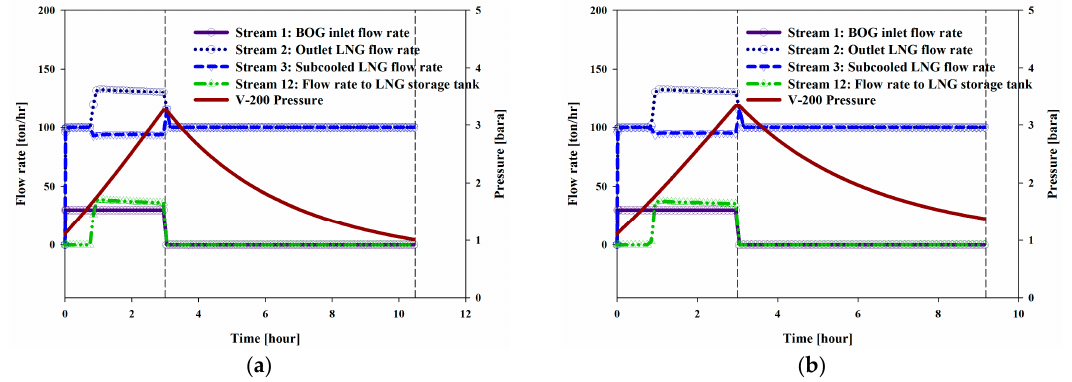
Figure 12. ( a ) Flow rate trends for DS-case IV; and ( b ) flow rate trends for DS-case V.